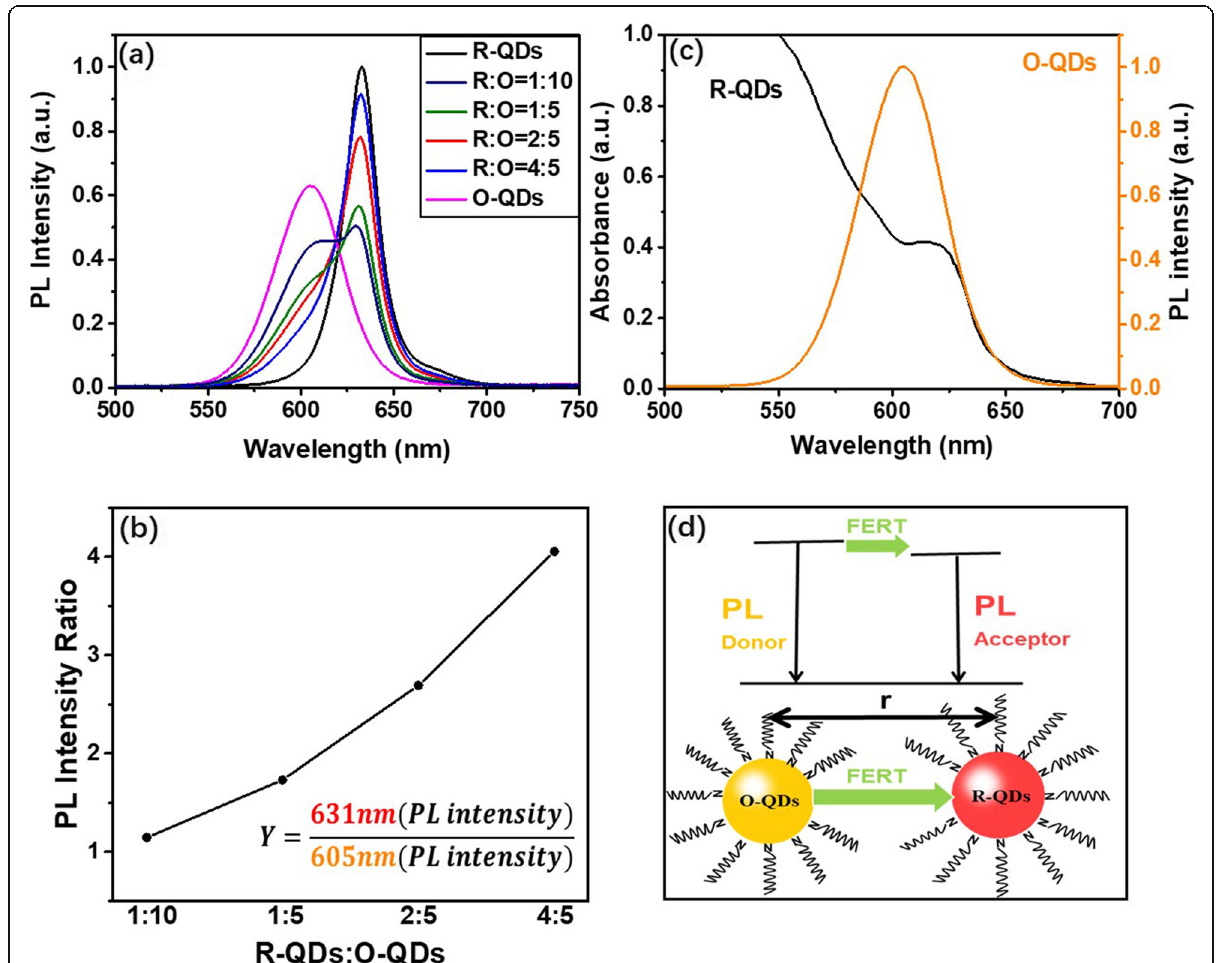
Fig. 4 PL spectra of composite-QD silicone thin films with different R-QDs to O-QDs ratio ( a ) and the composite-QD PL peak intensity ratio ( b ). The overlap of the R-QD absorption spectrum and O-QD emission spectrum ( c ). Schematic diagram of energy transfer in composite-QDs ( d